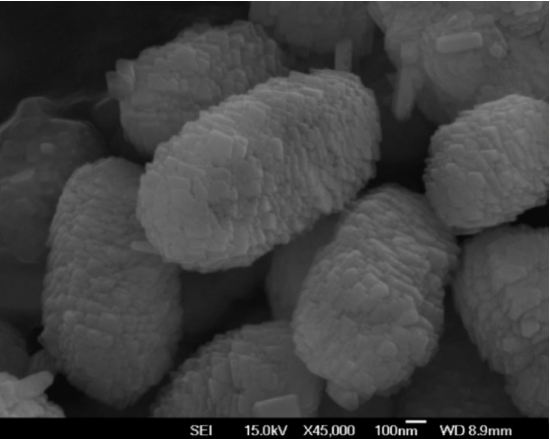
Figure 5. A high-resolution scanning electron microscopy image of rod-shaped alginate- CaCO 3